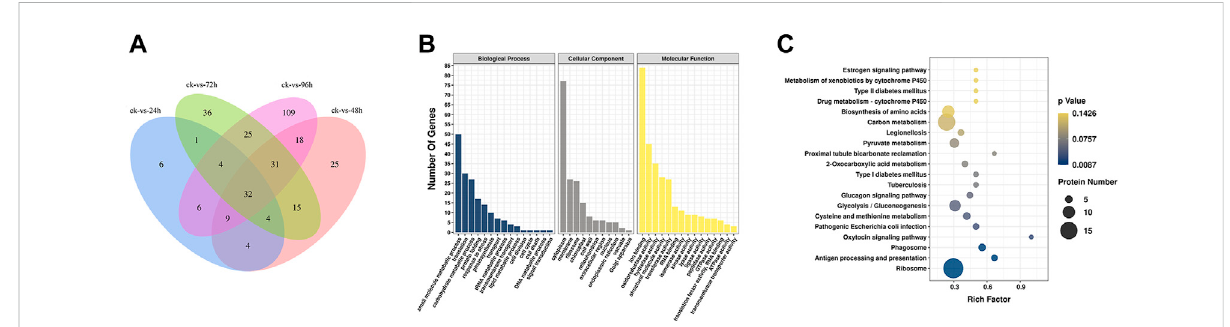
FIGURE 3 (A) Venn diagram of DEPs in E. ulmoides compared before (ck) with 24, 48, 72, and 96 h of inoculation with F. oxysporum , respectively. (B) GO analysis of DEPs in E. ulmoides between 0 and 72 h of inoculation with F. oxysporum . (C) KEGG enrichment analysis of DEPs in E. ulmoides between 0 and 72 h of inoculation with F. oxysporum